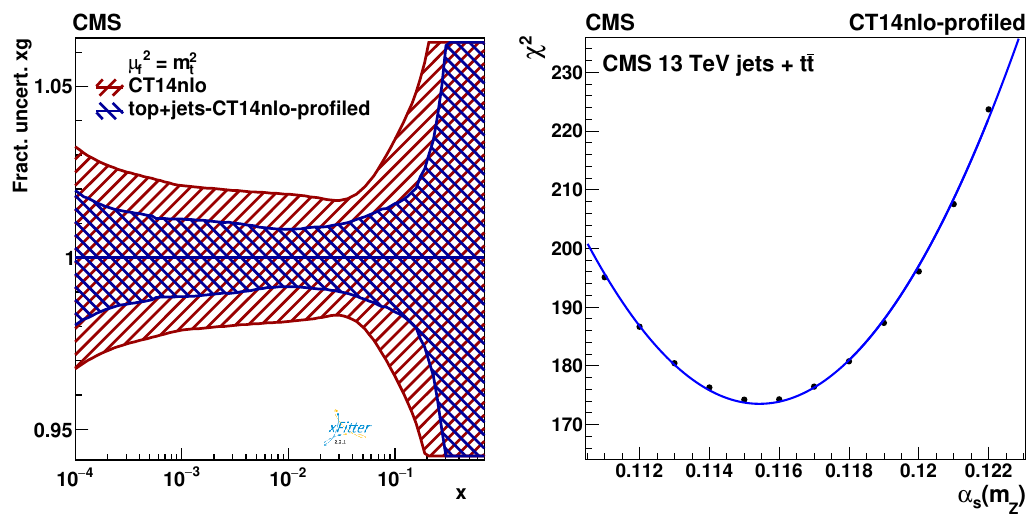
Figure 12 . Fractional uncertainty in the gluon distribution (left), shown as a function of x for the scale µ = m . The profiling is performed using CT14nlo PDF at NLO, by using the CMS inclusive f t jet and the triple-differential tt cross sections at is shown in red (blue). The χ 2 (right) obtained in profiling of CT14 PDF α same data as in